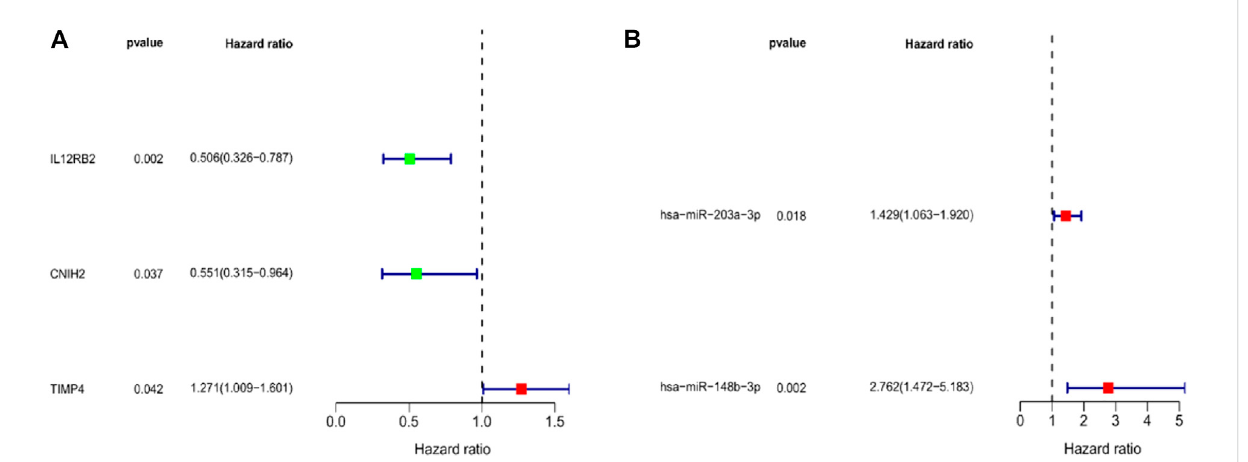
FIGURE 6 Forest map of univariate regression analyses. (A) Univariate Cox regression analysis for identi fi cation prognosis-associated mRNAs. (B) Univariate Cox regression analysis for identi fi cation prognosis-associated miRNAs.